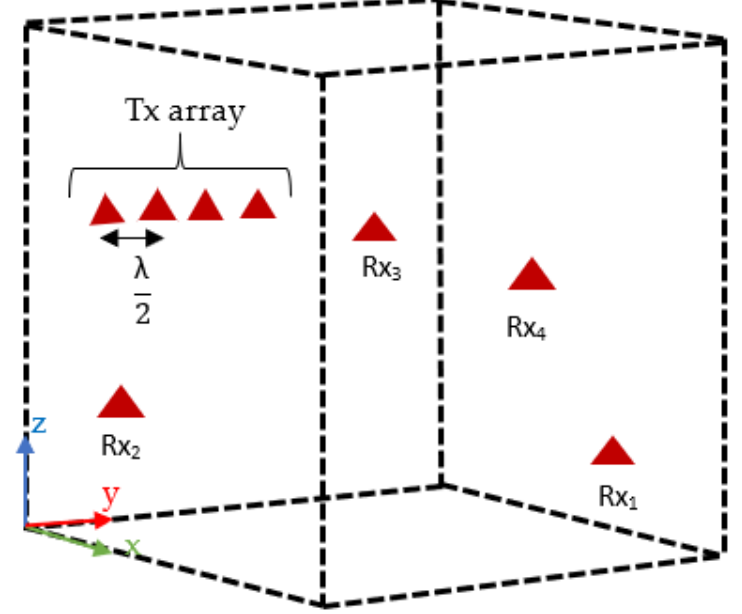
Figure 9. Multi-user scenario in indoor environment. Table 4. Average received power in watts for multi-user WPT scenario